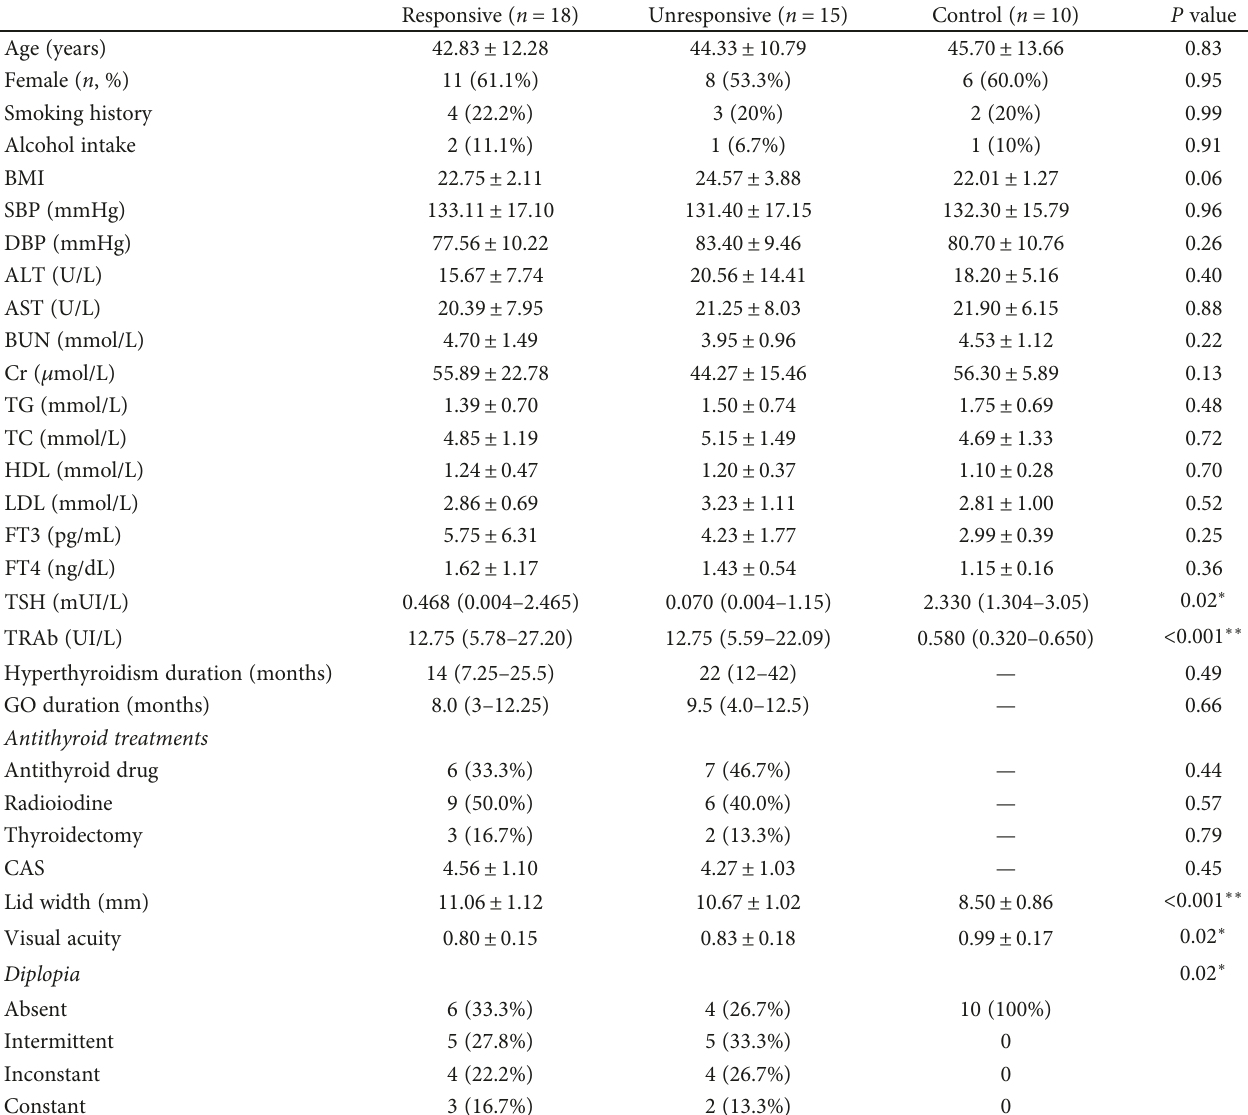
Table 1: Clinical features of each